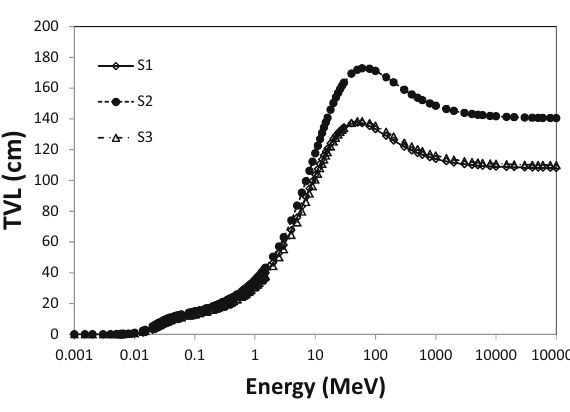
Figure 6: The HVL distribution with the gamma - ray energies.